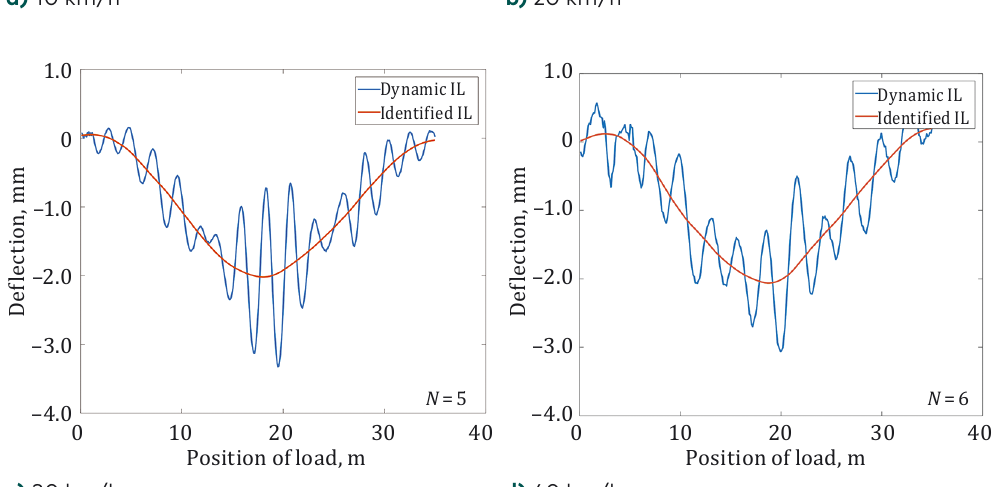
Position of load, m Position of load, Figure 9. Identified results of the dbN method